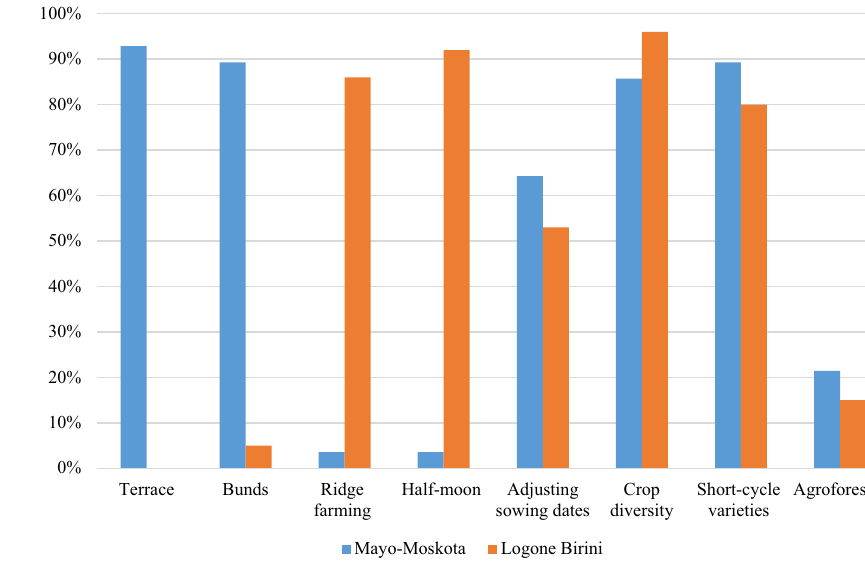
Fig. 2 Adaptation responses adopted by farmers in the study area